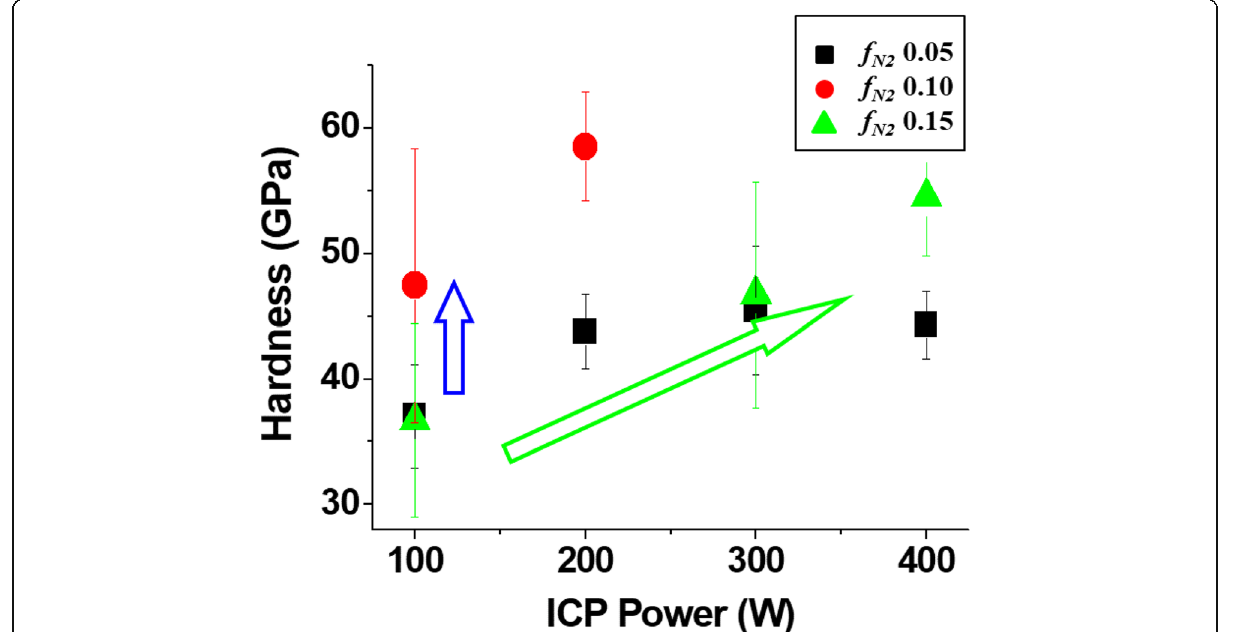
Fig. 1 Microhardness of TaN x films deposited by ICP sputtering, where ICP power was varied from 100 to 400 W at three nitrogen gas fractions ( f N2 ), 0.05 (black squares), 0.1 (red circles), and 0.15 (green